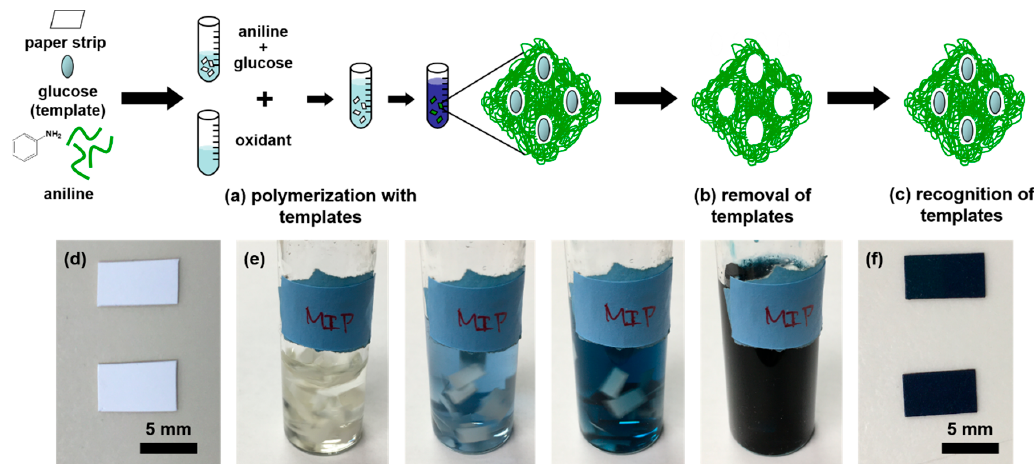
Figure 1. A schematic diagram of the molecular imprinting process for the fabrication of a paper sensor. The template represents glucose in this study. ( a ) Polymerization with templates. Glucose templates were mixed with aniline solution, the monomer, prior to the addition of the oxidant solution. Glucose-imprinted PANI, represented as the green regiment embedding templates in the schematic diagram, was then synthesized on the paper substrate. ( b ) Removal of glucose templates by washing the paper strips with deionized (DI) water. The cavities left in the polymer matrix create the specific recognition sites for the corresponding targets. ( c ) Recognition of templates on the paper sensor when conducting the glucose concentration measurement. ( d ) The polyester paper was cut into strips before polymerization. ( e ) The color of the polymerization solution changed from yellowish to light blue and finally became dark blue due to the doping process. The paper strips were completely immersed and were subject to vigorous stirring in the solution during polymerization. ( f ) The prepared paper strips with glucose imprinted PANI synthesized on both sides of the surface after the glucose removal process by washing with DI